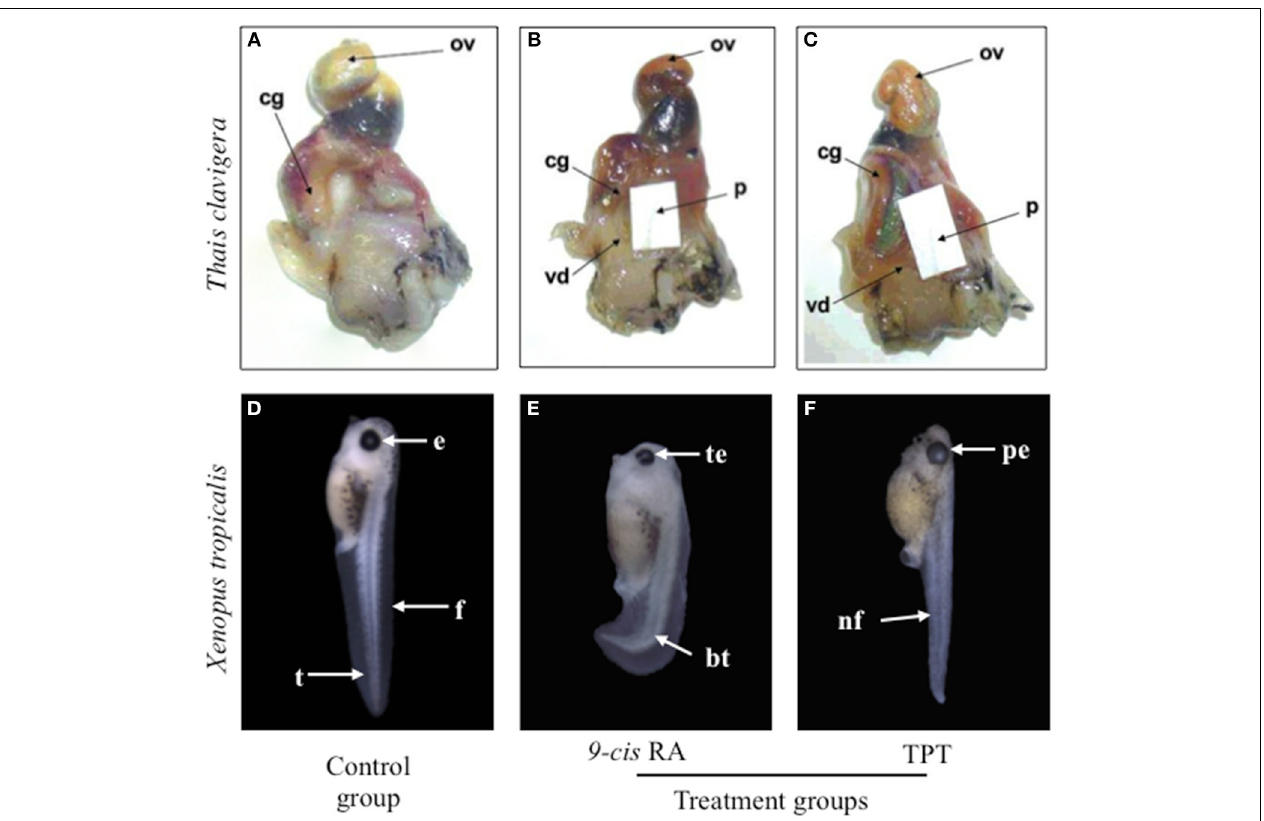
FIGURE 1 | Comparison of toxic effects of triphenyltin (TPT) and 9-cis retinoic acid ( 9c- RA) on snail ( Thais clavigera ) (A–C) and frog ( Xenopus tropicalis ) (D–F). Photographs of (A–C) were cited from Nishikawa et al.